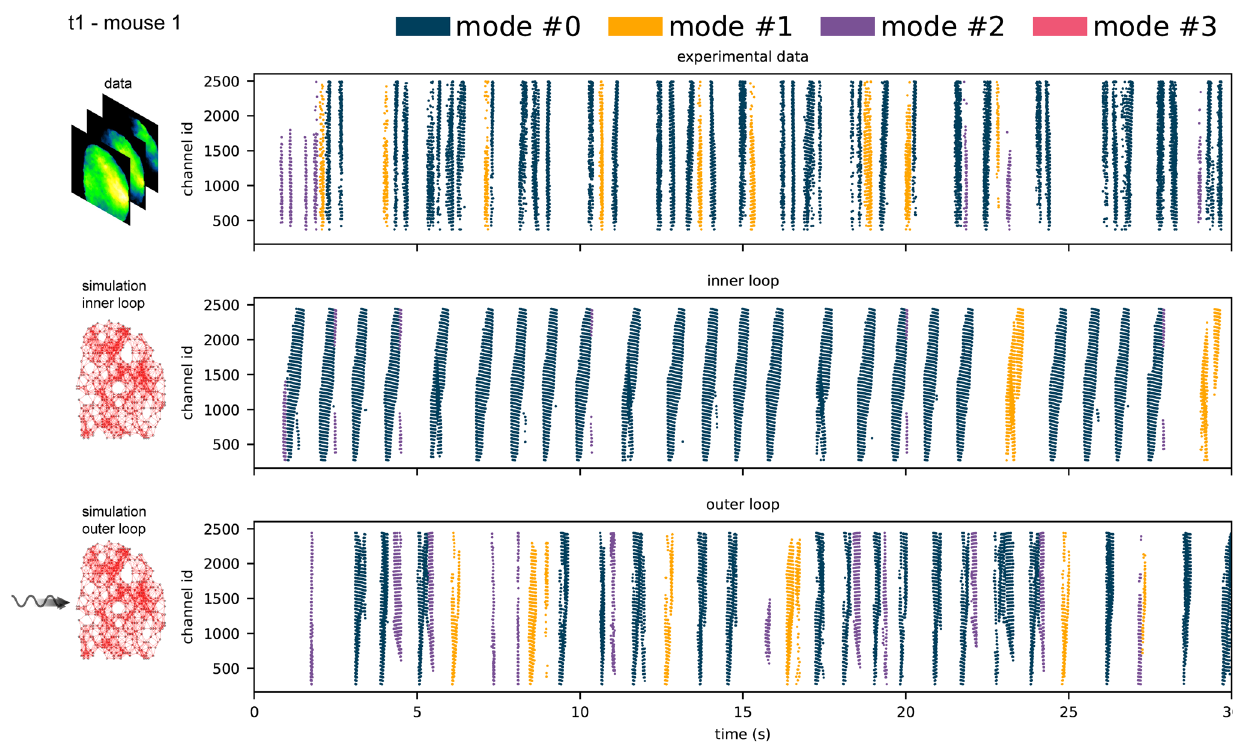
Fig. 5 Dynamics comparison. Raster plot of the detected waves in experimental data (top), in simulated data without neuro-modulation (output of the inner loop, center), and in simulated data with optimal neuro-modulation (output of the outer loop, bottom). For visualization purposes, only 30 s out of the 40 s of the recording (mouse 1, trial 1) are reported. All the waves detected in the three scenarios are classi fi ed though a GMM approach; the four GMM modes are identi fi ed from fi tting the collection of experimental + simulated waves of all trials. In this chunk speci fi cally, the fourth mode (pink) is not found. Wave colors indicate the resulting modes of